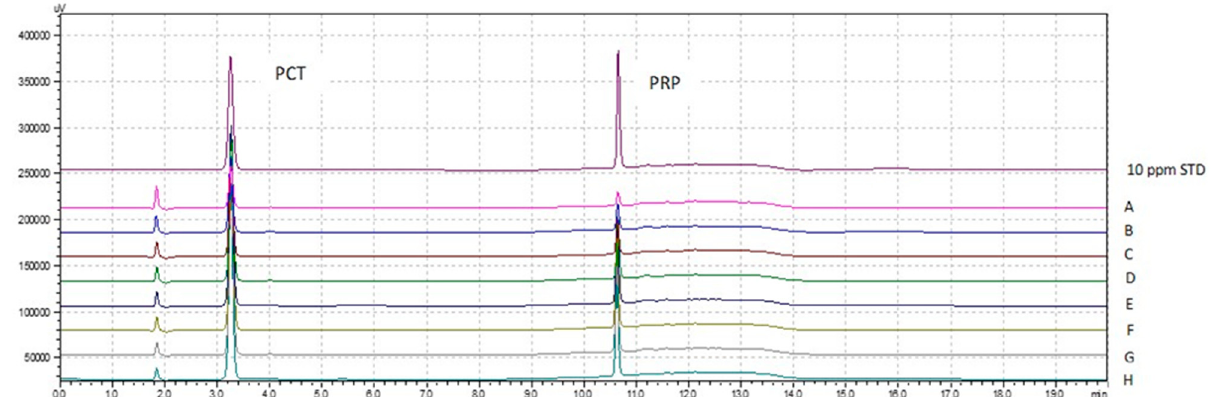
Figure 1. Overlay of representative HPLC-UV chromatographs from analysis of a standard (60:40) mixture of paracetamol (PCT) and propyphenazone (PRP) (10 μ g mL − 1 ) and chromatographs of dissolution samples drawn at 5, 10, 15, 30, 45, 60, 90 and 120 min (A, B, C, D, E, F, G, H, respectively).